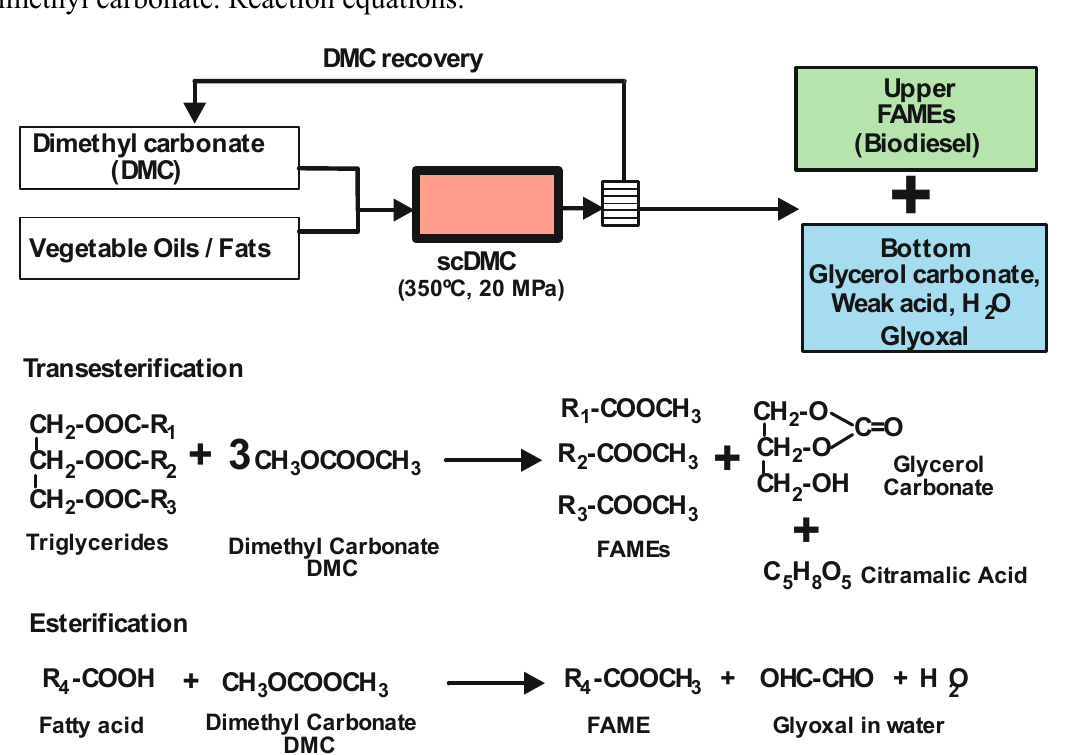
Figure 3. Non-catalytic one-step process for biodiesel synthesis using supercritical dimethyl carbonate. Reaction